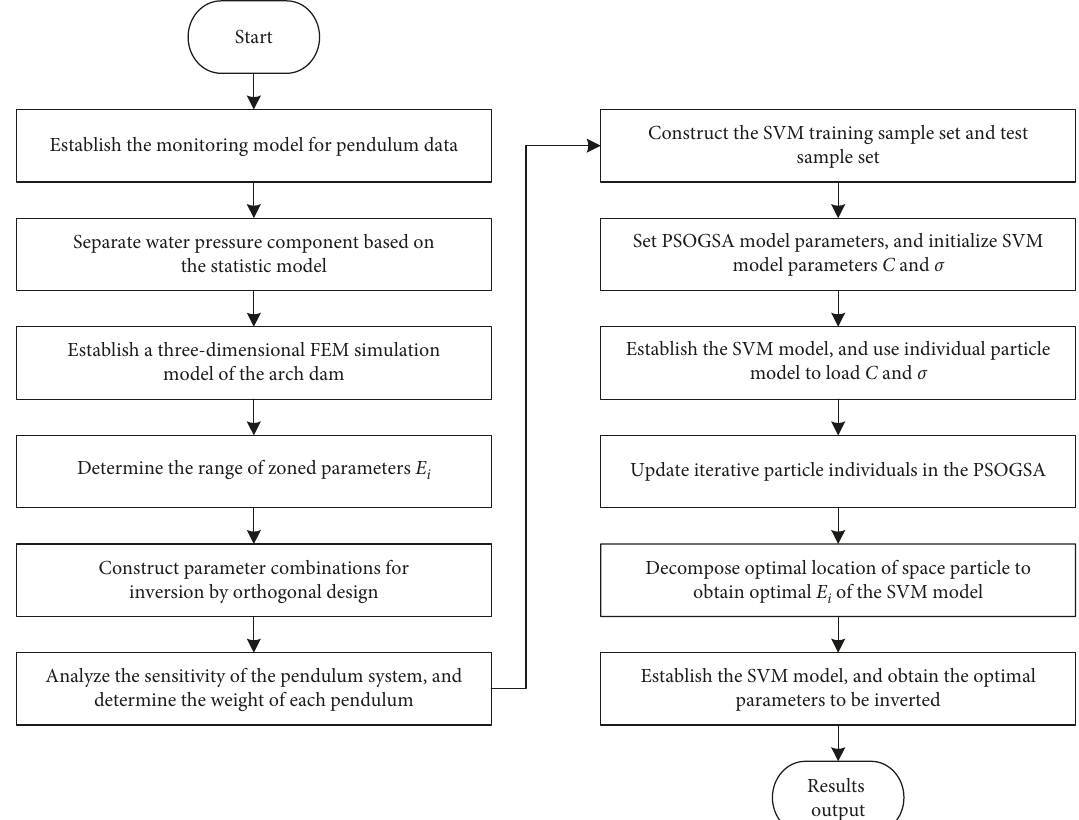
Figure 3: PSOGSA-SVM inversion process of zoning high arch dams.